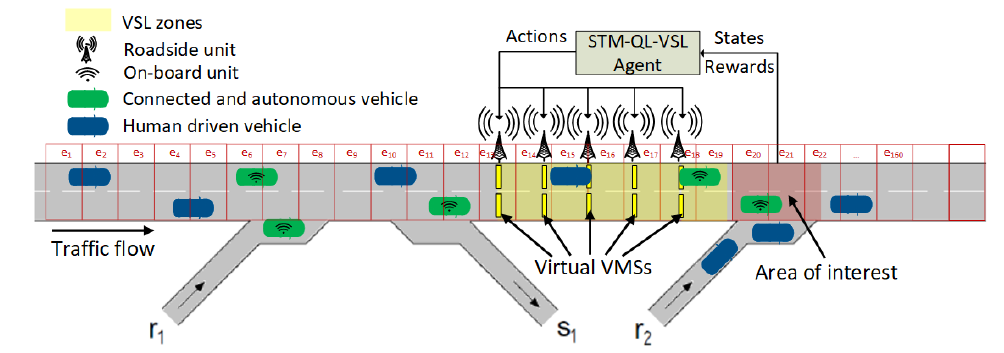
Figure 3. Configuration of the simulation model and VSL controllers. Adapted with permission from Refs. [5,7,8]. 2023, Filip Vrbani´c.